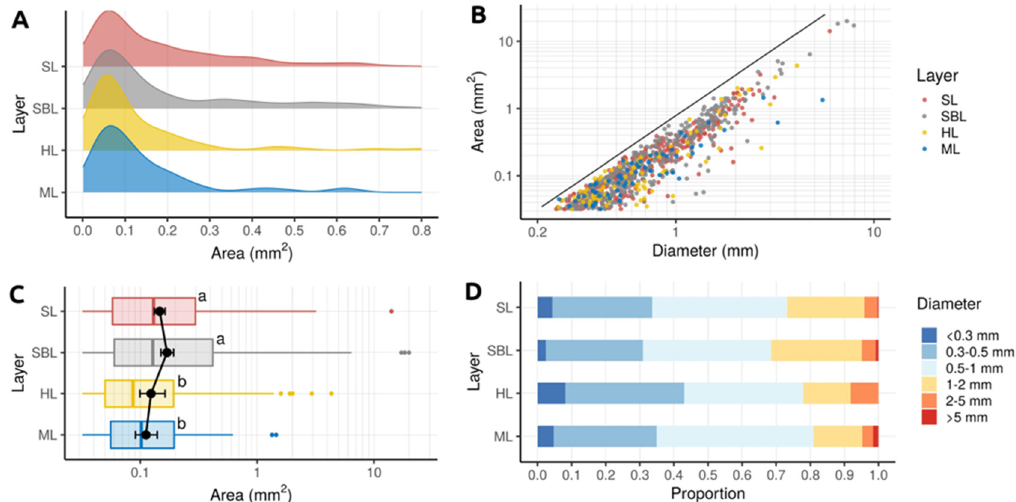
Figure 3. ( A ) Size distribution (area) of particles in each layer ( B ) Boxplot representation of size (area) in logarithmic scale. Significant differences between log-transformed groups are indicated with different letters, and error bars represent 95% confidence intervals (CIs) around the mean. ( C ) Two measures of particle size: diameter and area. The line represents the theoretical relationship between diameter and area when the cross-section of the particle is circular (area = π /4 × diameter 2 ). ( D ) Distribution of particle size (diameter) among six size classes.